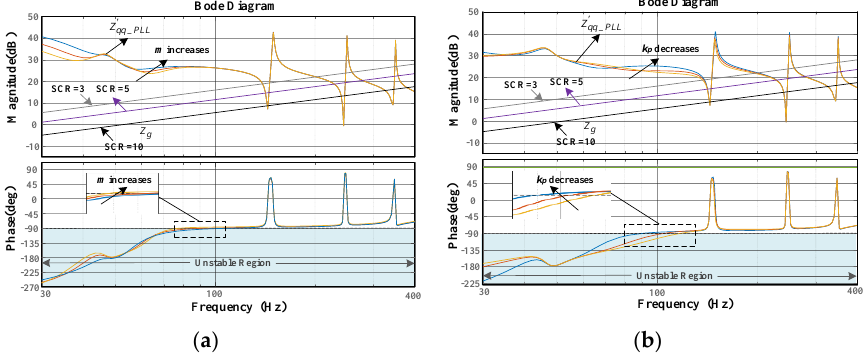
Figure 12. Bode plot of qq_ ( ) PLL Z s  with the change in m and k p : ( a ) m changes, k p is constant; ( b ) k p changes, m is